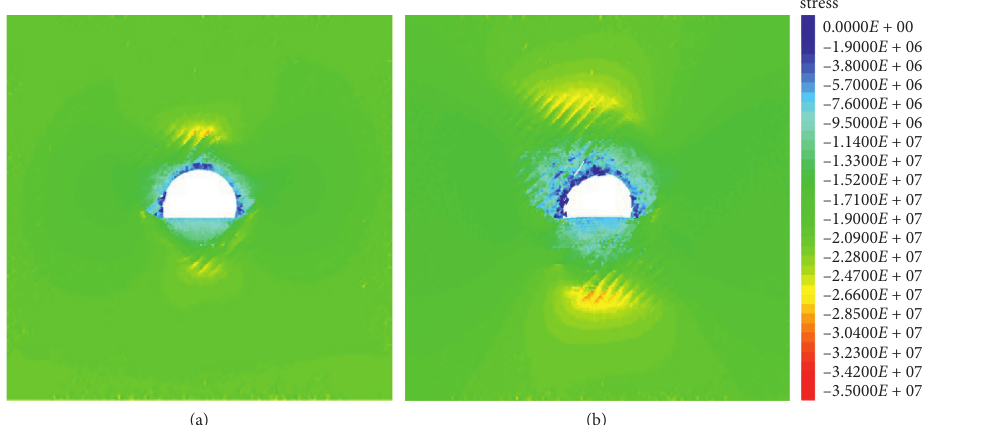
Figure 10: Distribution of maximum principal stress corresponding to a 45 ° inclination of joints: (a) step 2000 and (b) step 6000.